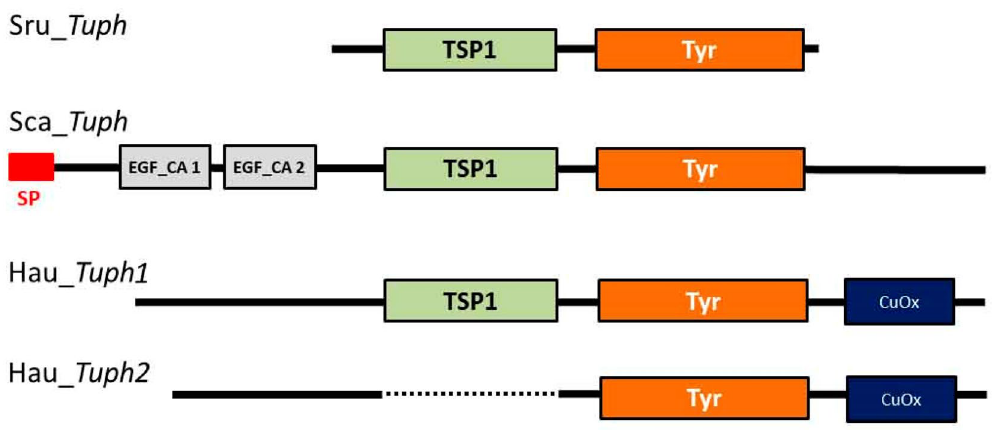
Figure 4. Diagram of domain composition based on the alignment of four predicted amino acid sequences encoded by Tuphoxins of S. rustica (Sru_ Tuph ) , S. canopus (Sca_ Tuph ) and H. aurantium (Hau_ Tuph1,2 ).